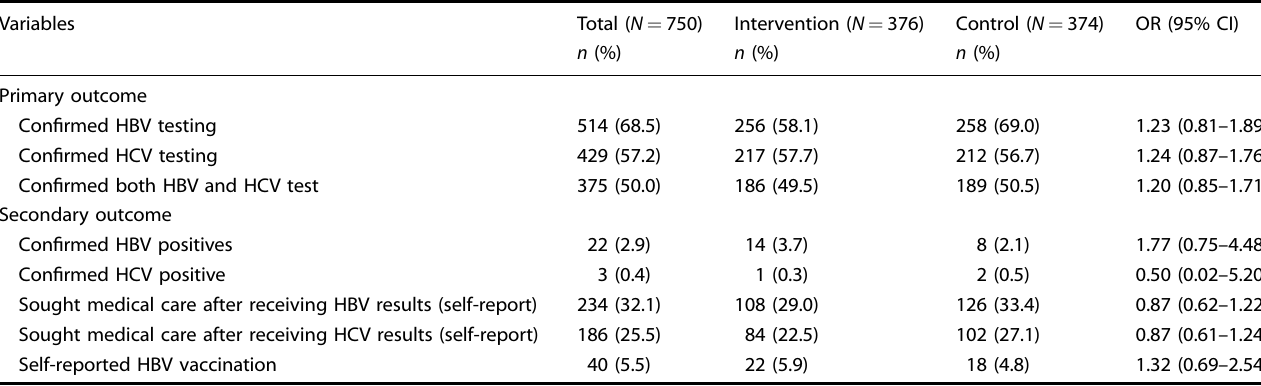
Table 2. Intention-to-treat analysis of primary and secondary outcomes for an online randomized controlled trial to evaluate the impact of a crowdsourced intervention on hepatitis test uptake among 750 primary care users in urban China, 2019 – 2021. Variables